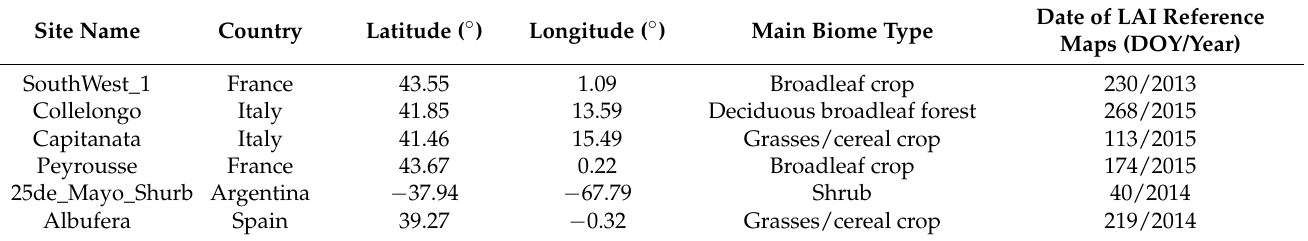
Table 1. Characteristics of the six selected